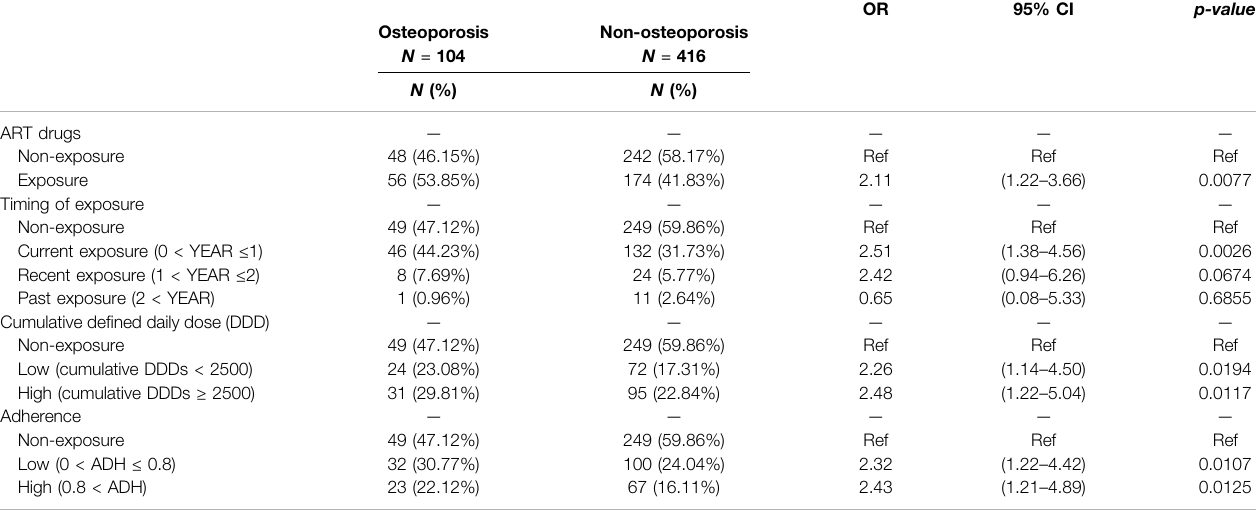
TABLE 2 | Risk of osteoporosis when exposure to ART